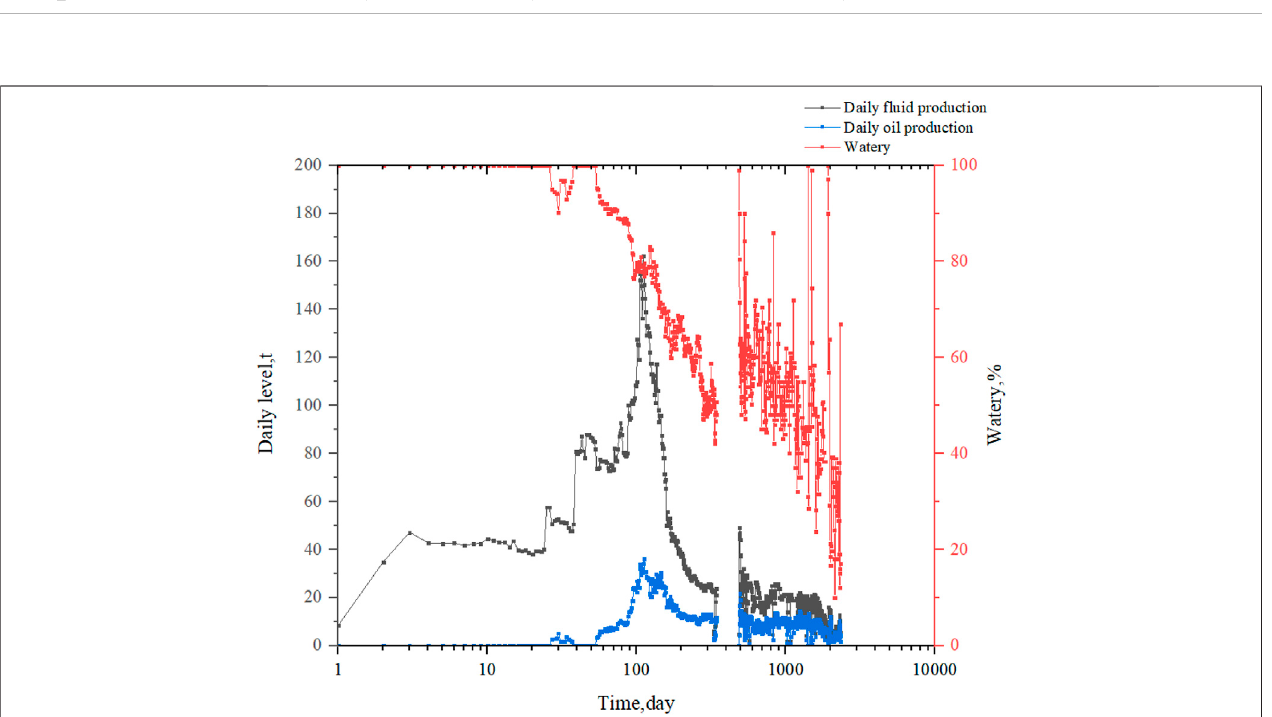
FIGURE 3 | Production performance curve of Well